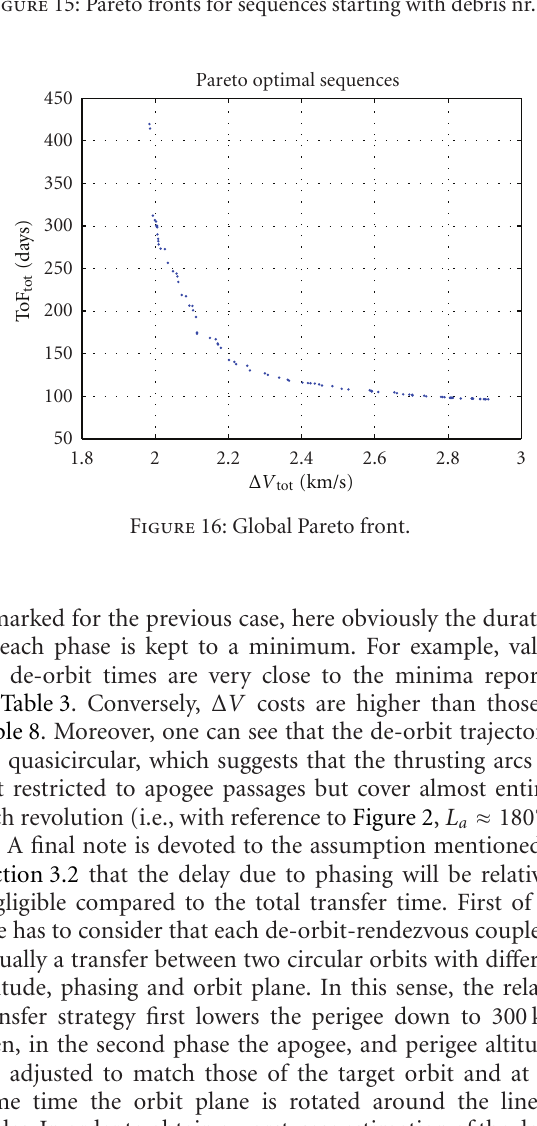
Figure 15: Pareto fronts for sequences starting with debris nr. 5.